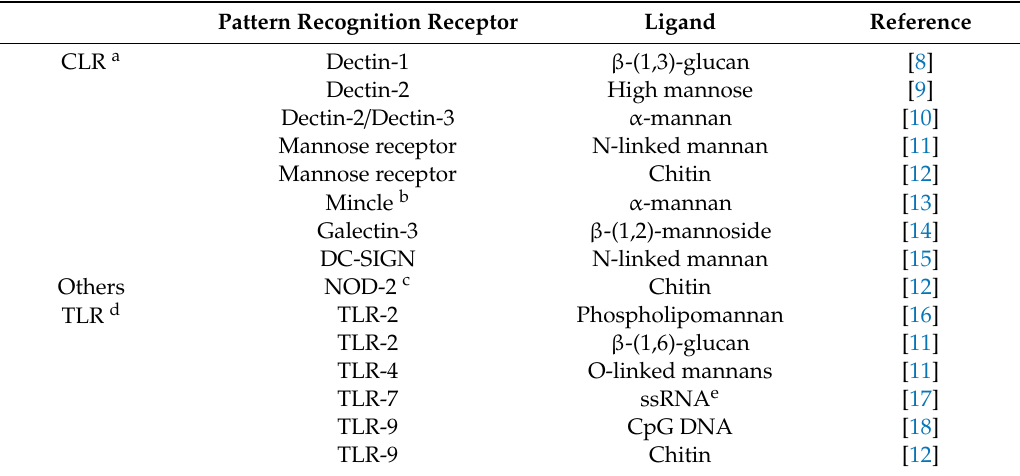
Table 1. Fungal pattern recognition receptors and their